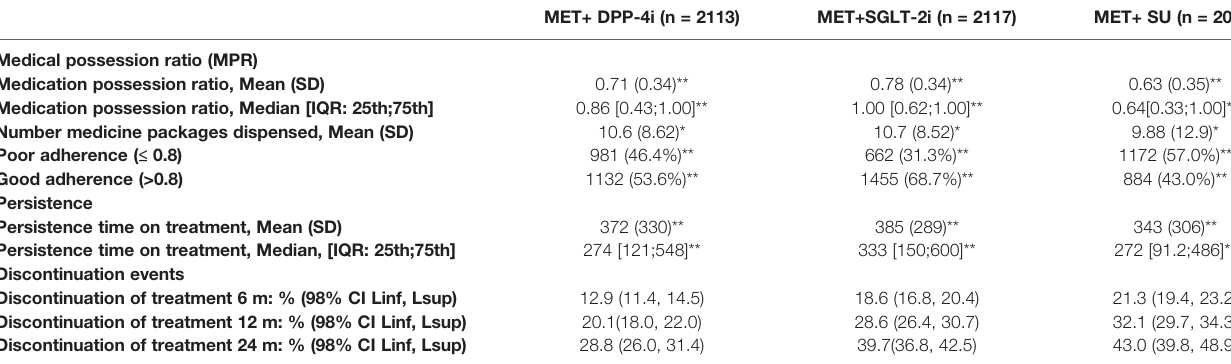
TABLE 1 | Medical possession ratio, adherence, persistence (time until discontinuation and discontinuations) among the three treatment groups.